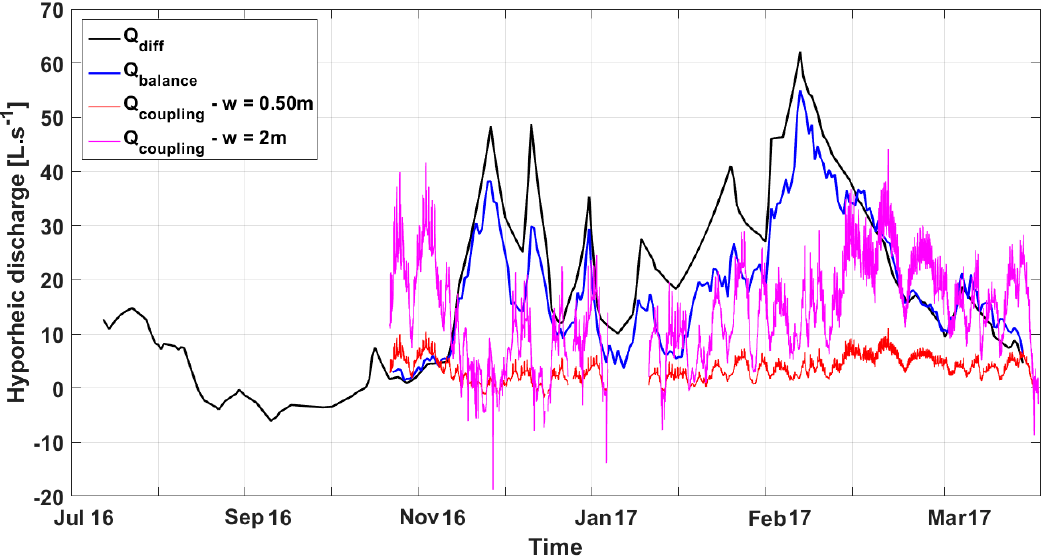
Figure 9. Comparison of three methods for quantifying hyporheic discharge along the 400 m long reach between gauging stations: differential gauging (Q diff ), heat-balance method (Q balance ), and the method coupling distributed temperature sensing mapping and vertical flow velocities (Q coupling ).